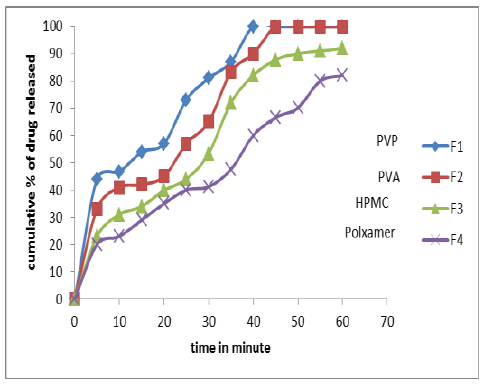
Figure (1): Effect of polymer type on the dissolution profile of ezetimibe nanoparticles from F1, F2, F3, and F4 in 0.1 N HCl solution (pH 1.2) containing 2% brij- 35 w/v at 50 r.p.m and 37˚C temperature .